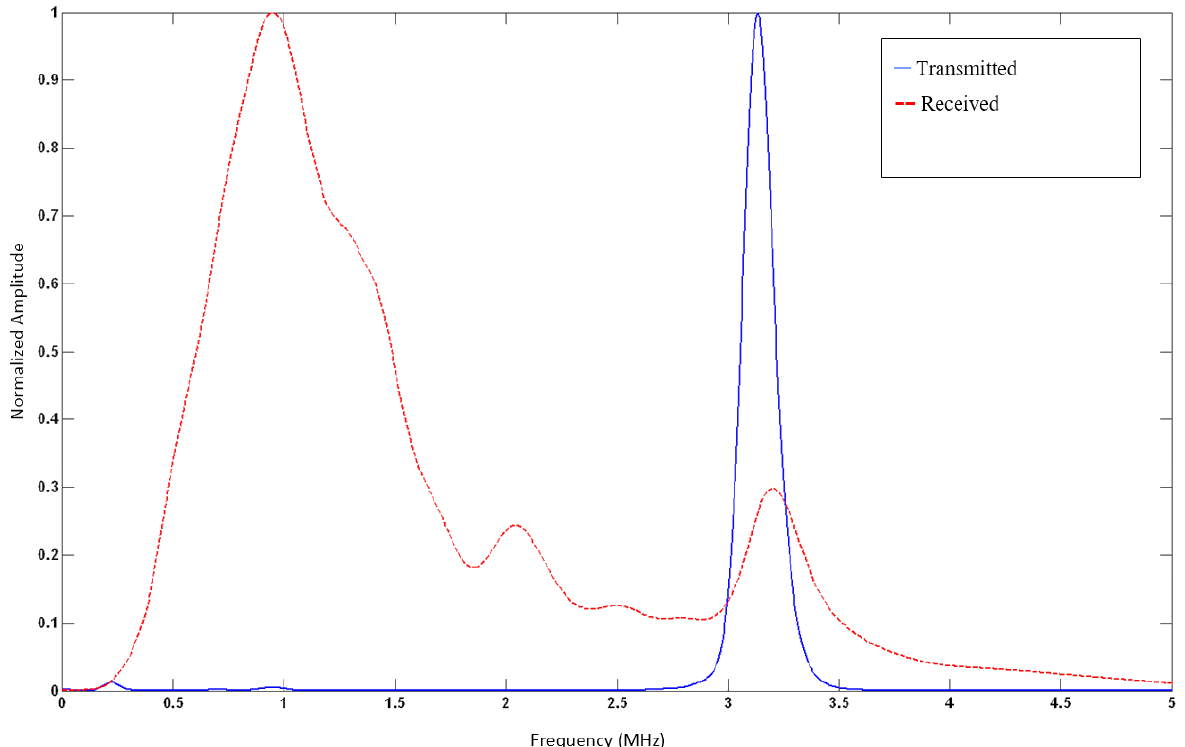
Figure 5. Normalized spectral density characterization of the acoustic pressure wave is seen in Figure 3. Central frequency ( f c ) is at 3.13 MHz, with a Q-value of 18.4. An estimated Gaussian envelope of the wave can be readily identified.